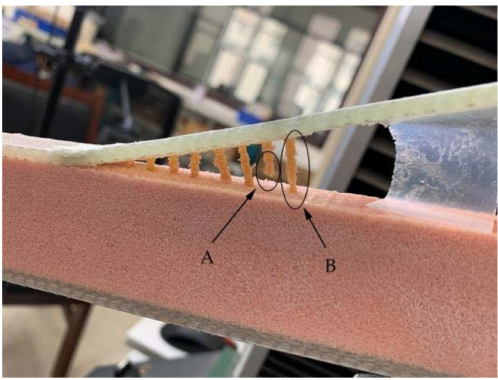
Figure 9. Fracture and pull-out of the resin column (A is the fracture of the resin column, and B is the pull-out of the resin